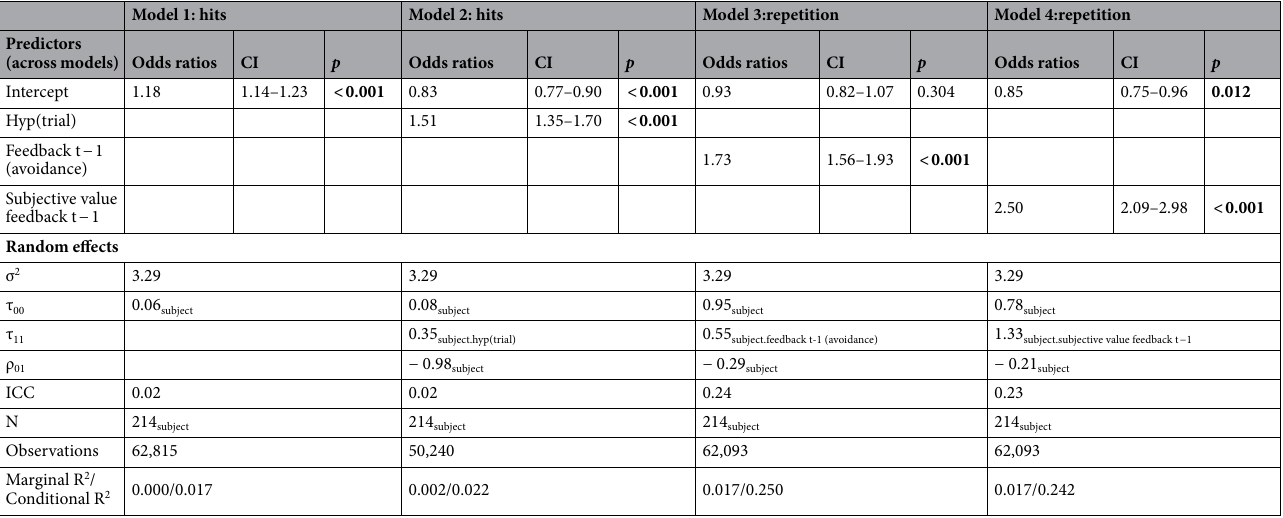
Table 1. Mixed logistic models. Random effects: σ 2 = Residual variance, τ 00 = random intercept